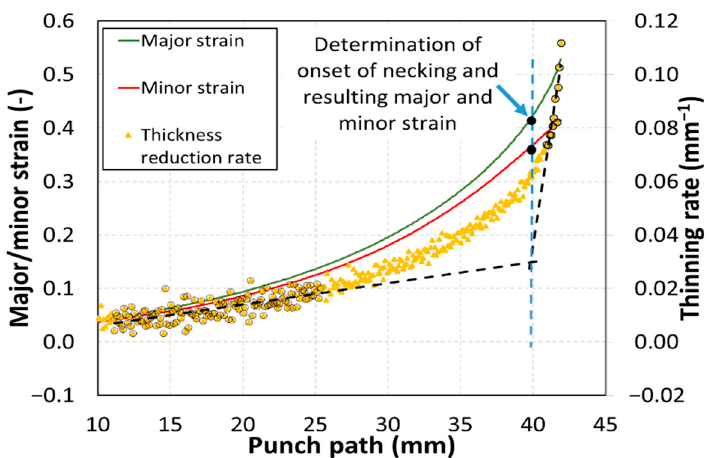
Figure 3. Determination of the FLD values, time-dependent method—2012 approach.